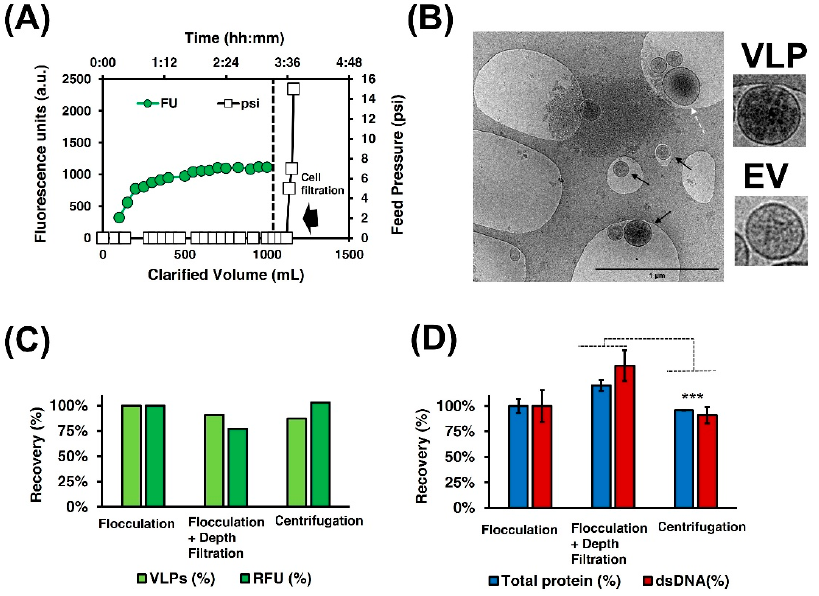
Figure 2. Clarification of Gag ‐ eGFP VLPs. ( A ) At ‐ line monitoring of depth filtration process, fluo ‐ rescence units (FU) in the clarified volume, and feed pressure (psi) were measured with time. ( B ) Cryo-TEM micrographs of clarified material after filtration. Black arrows indicate the presence of VLPs, while white dashed arrows point to the EVs. Flocculation, flocculation and depth filtration, and centrifugation as the reference clarification strategy were analyzed (C ‐ D); VLP measured by flow virometry (VLPs), relative fluorescent units (RFU) ( C ), total protein and dsDNA ( D ) recoveries (%) in respect to flocculation are compared between processes, respectively. Statistical analyses of technical replicates were performed with the T Student test in total protein and dsDNA quantifica ‐ tions. Ns: non ‐ significant, ***: p ‐ value ≤ 0.001